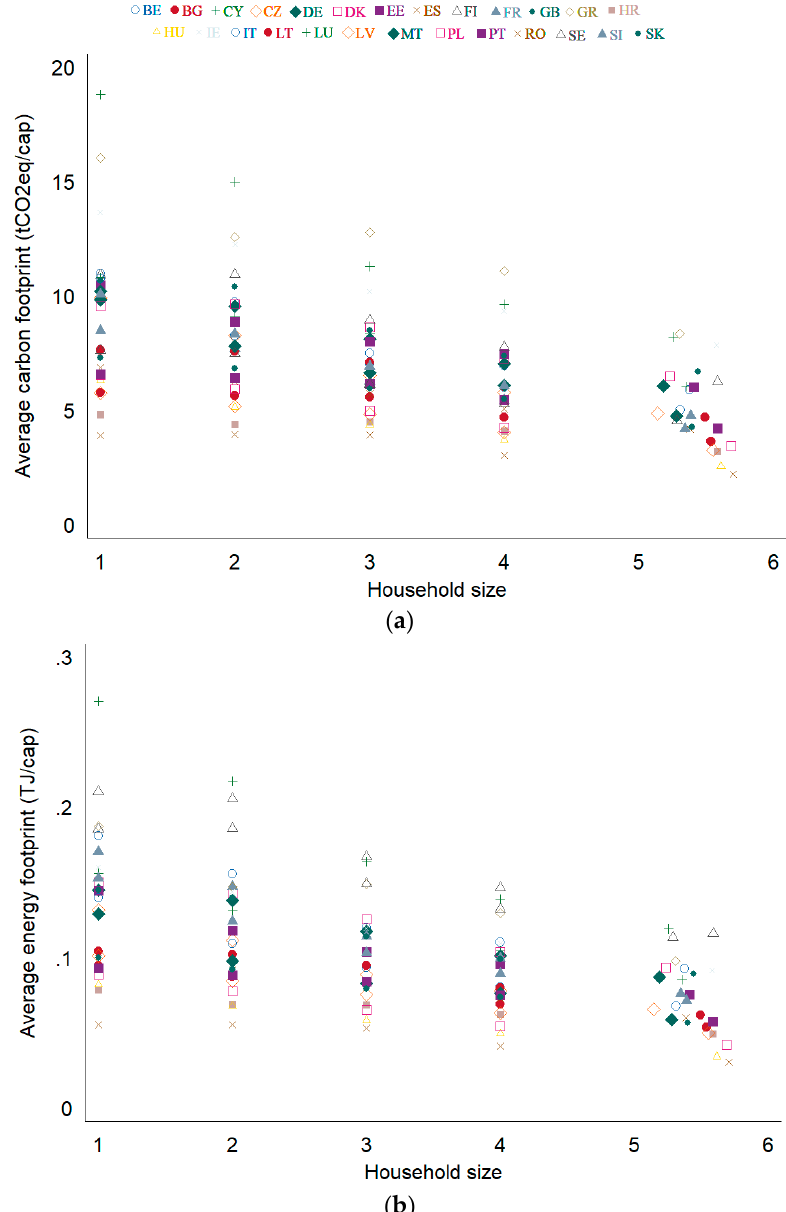
Figure 3. Mean per capita carbon ( a ) and energy ( b ) footprints by EU country by household size. Households with household sizes >5 have been aggregated in the same group. The carbon footprints are measured in tCO 2 eq/cap and energy footprints in TJ/cap. Household weights provided by the HBS have been applied.